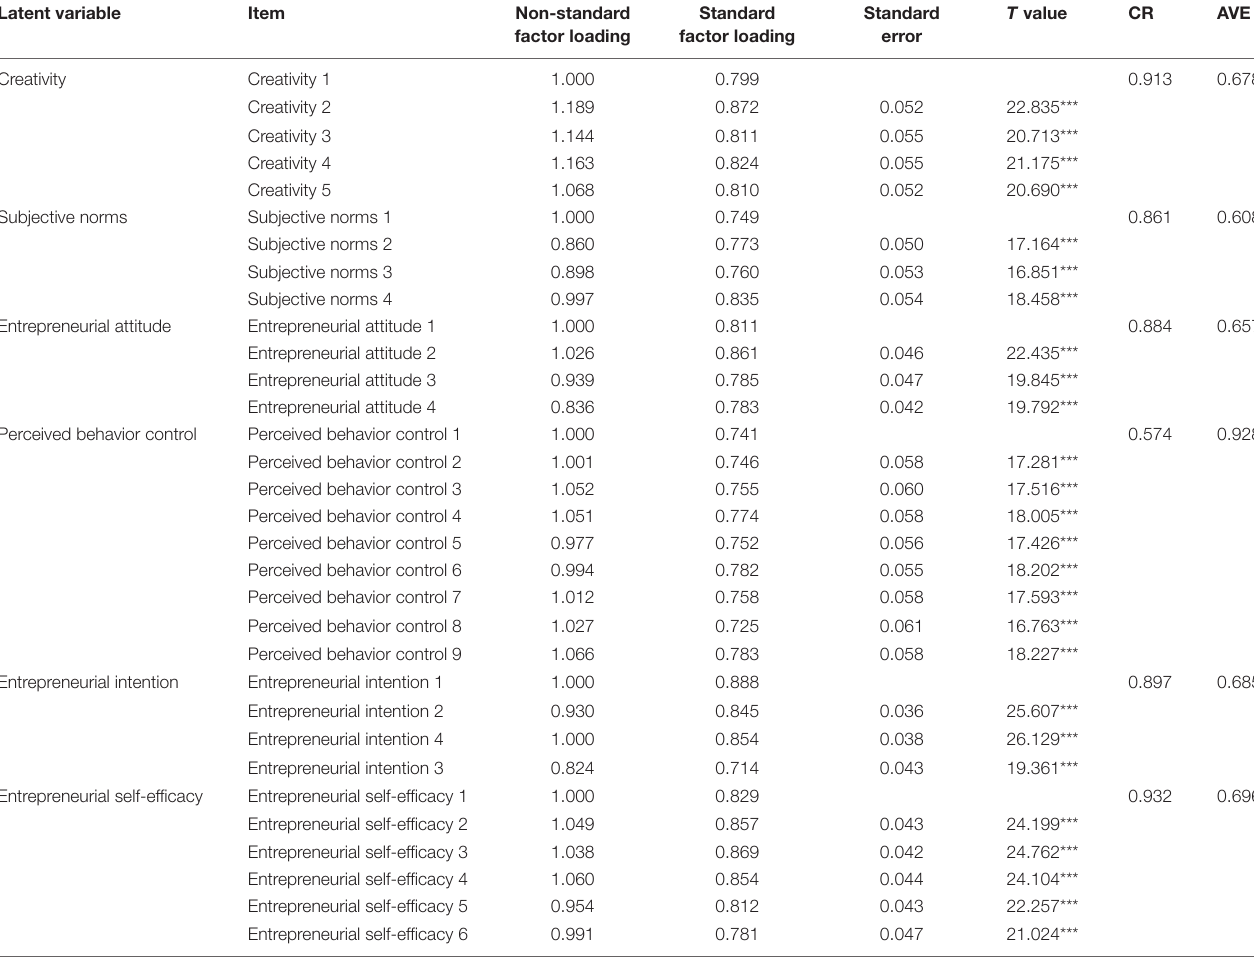
TABLE 2 | Convergent validity analysis results.